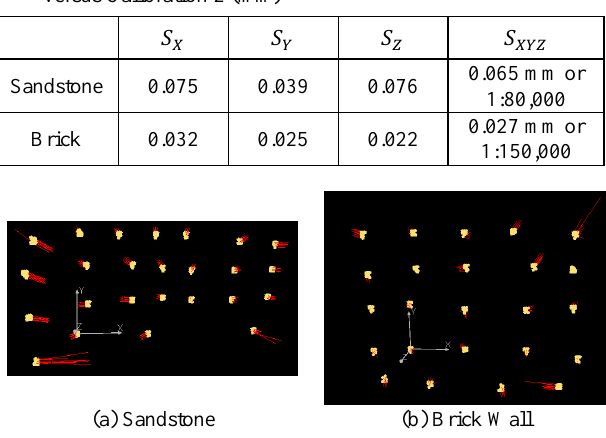
Figure 7. Object point discrepancies from network solutions using different calibration parameter